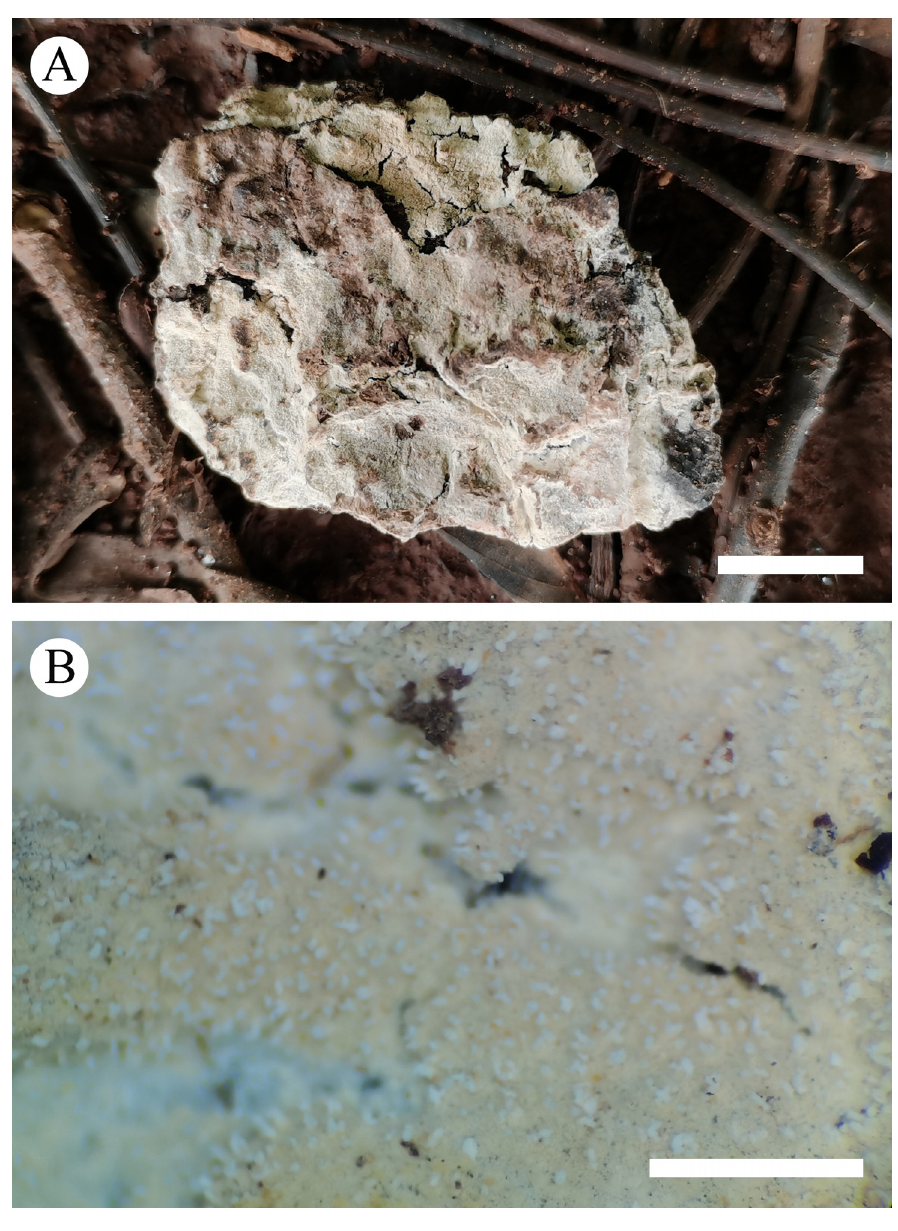
Figure 9. Basidiomata of Xylodon sinensis (holotype). Bars: a = 1 cm and b = 1 mm.